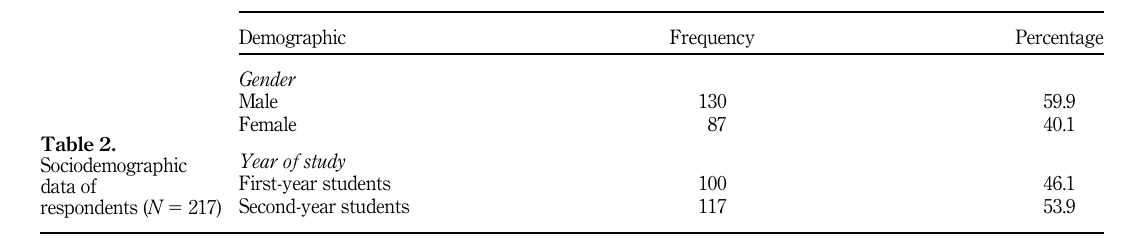
Table 3. Test of significance of correlation of